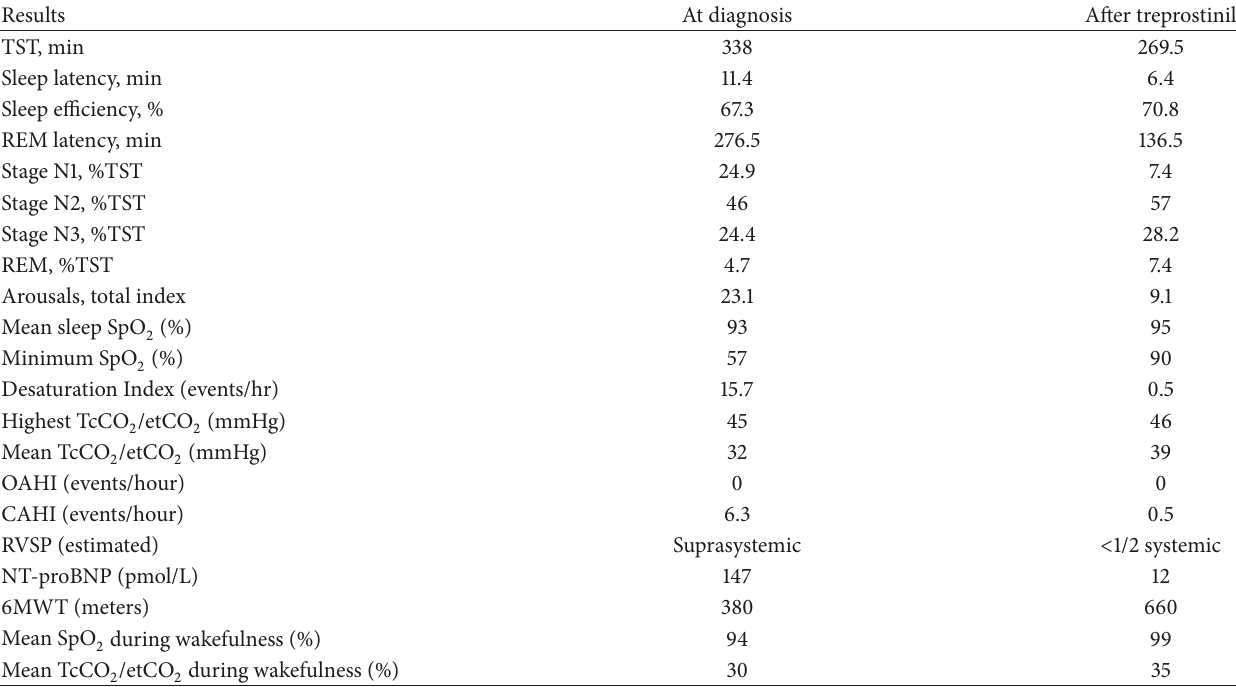
Table 1: PSG results of the patient before and after treprostinil and oxygen